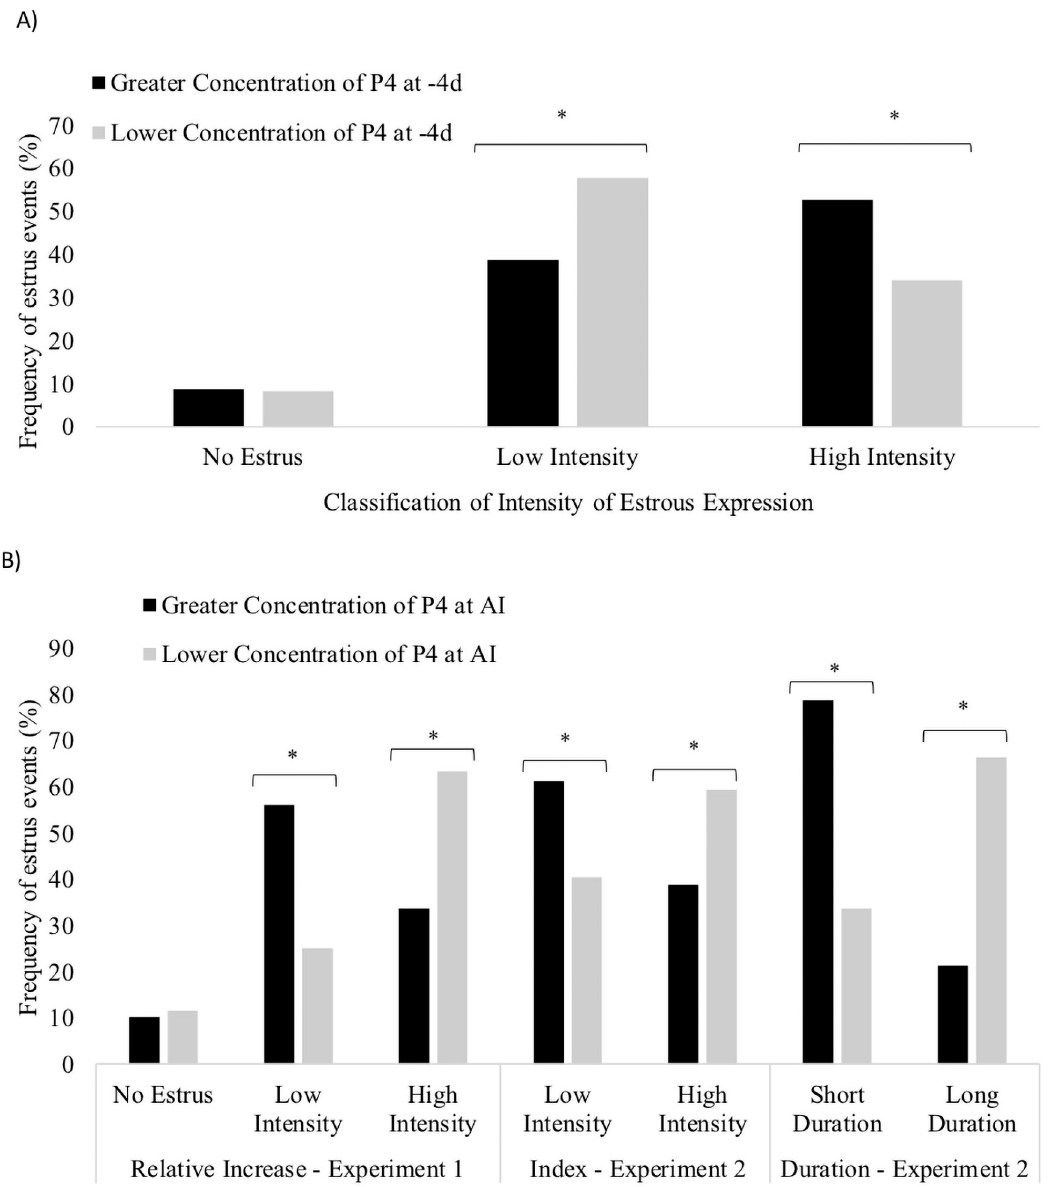
Fig 3. Proportion of cows displaying greater and lesser estrous expression according of the concentration of P4 at -4 d (Experiment 1, Panel A; P < 0.01), and the concentration of P4 at 0 d (Experiment 1 and Experiment 2, Panel B; P < 0.01).